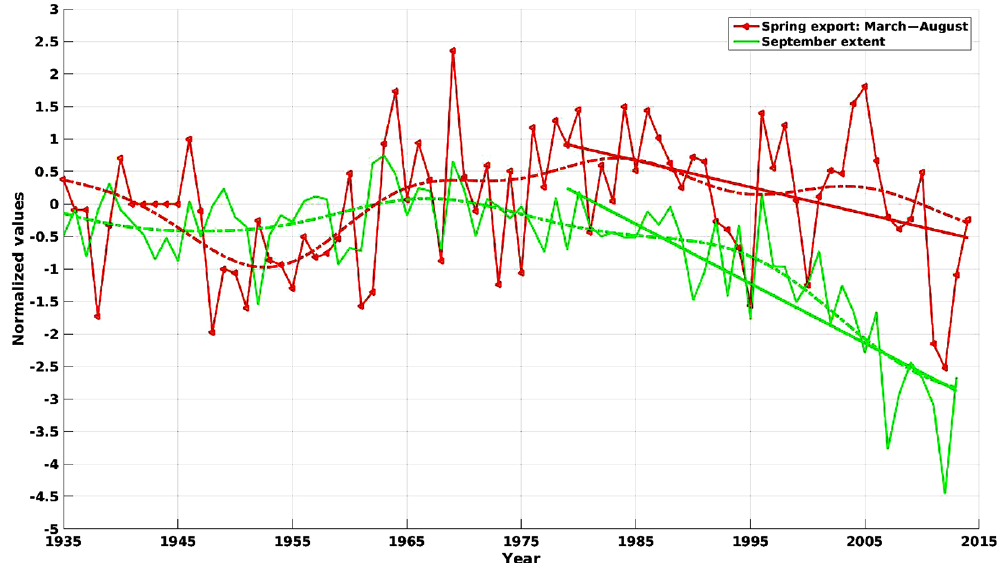
Figure 6. Spring Fram Strait ice area export (red) and mid-September Arctic SIE (green). The ice export is averaged for March 1st through 31 August. Both time series have been normalized by subtracting the mean and dividing with the standard deviation. The ice export is here plotted with negative values as high southward export for easier comparison. Smoothed time series are included, produced by filtering with a 20-year-cutoff eighth-order Butterworth filter. The 1979–2014 trends in ice export and mid-September SIE are shown as solid straight lines. SIE values are obtained from Walsh et al.